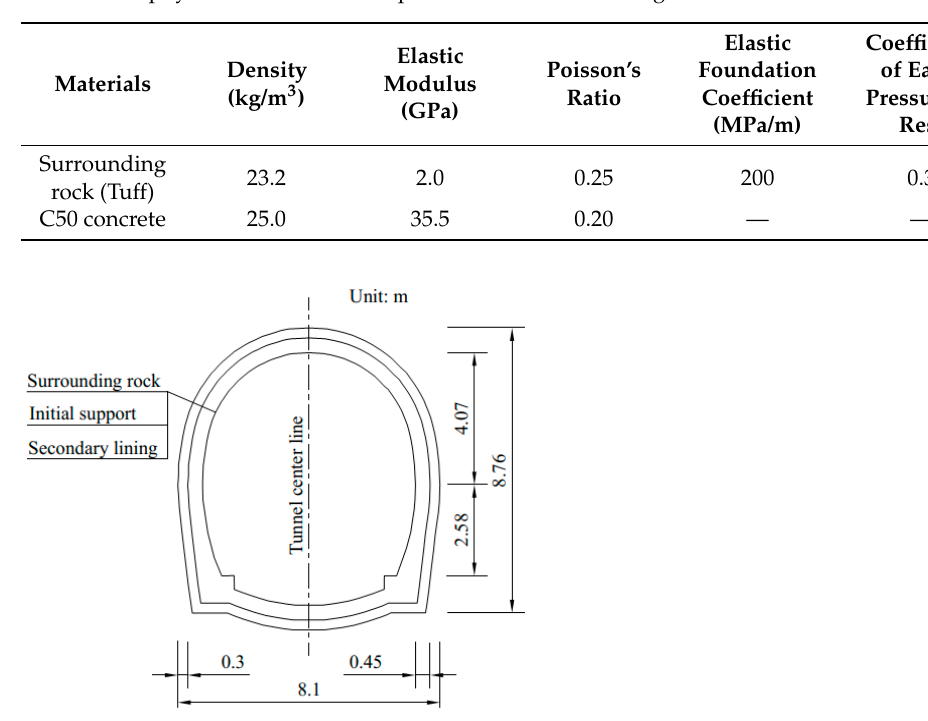
Table 7. The physical and mechanical parameters of surrounding rock and concrete.